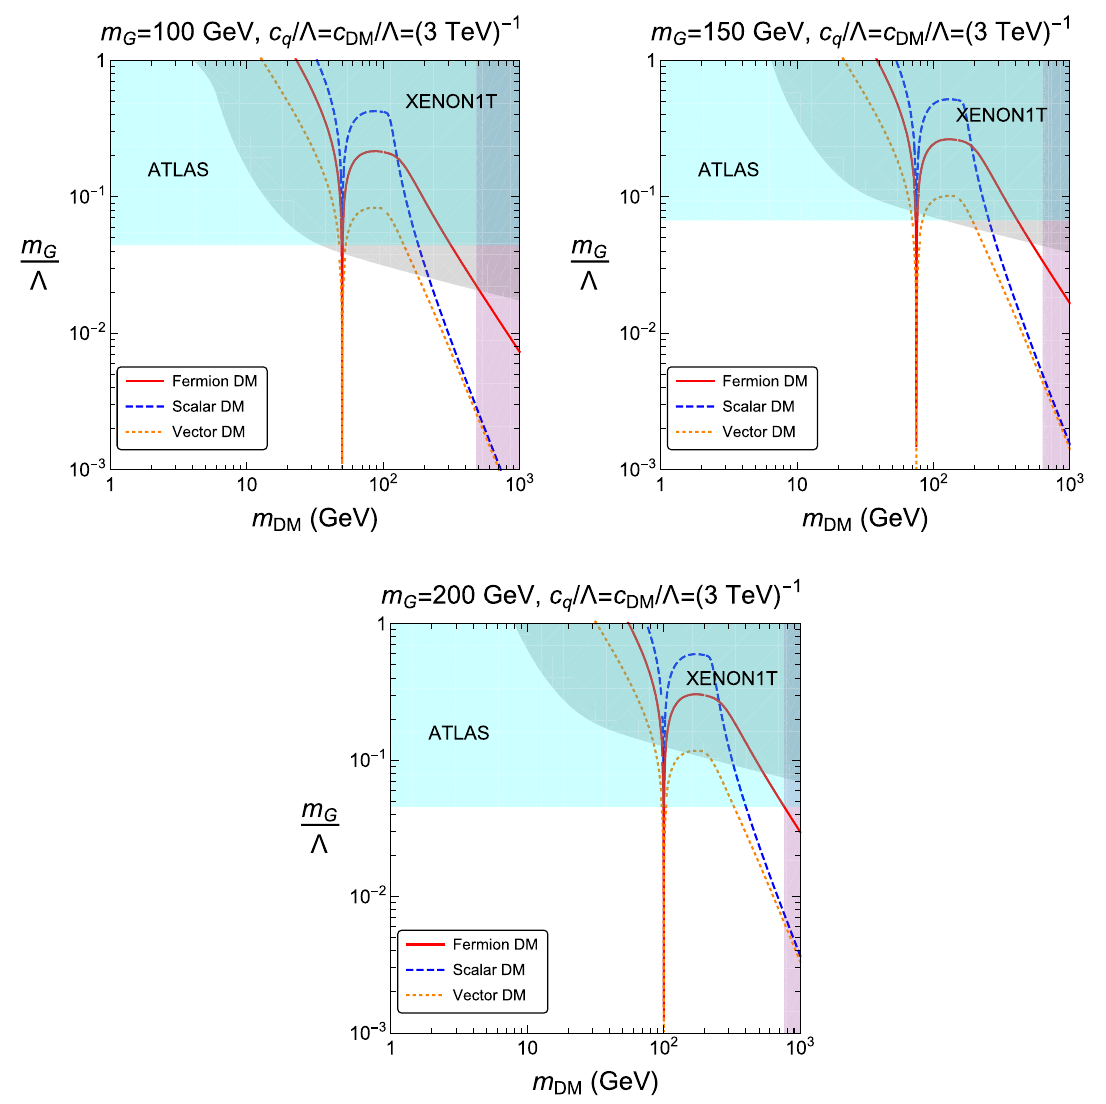
Fig. 1 Parameter space for m G /(cid:3) vs m DM for WIMP dark matter. The relic density is satisfied in red solid, blue dashed and orange dotted lines for fermion, scalar and vector dark matter, respectively. The gray region is excluded by XENON1T and the light blue region is excluded